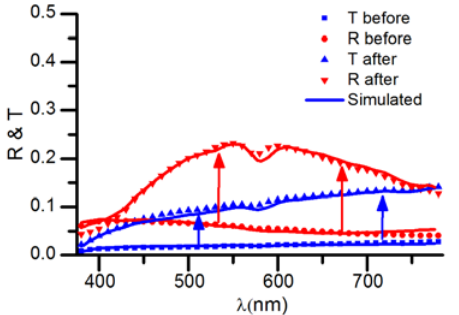
Figure 6. Effect of abandonment test on transmittance and reflectance spectra of navy/black coatings with SnO 2 and Sst layers. Experimental data (points) and simulated data (lines). Table 2. Film thicknesses (in nm) for simulated multilayer of SnO 2 /Sst after the abandonment test.